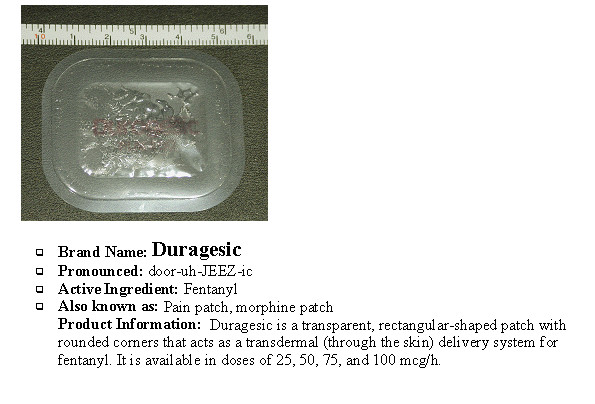
A sample opioid information card.